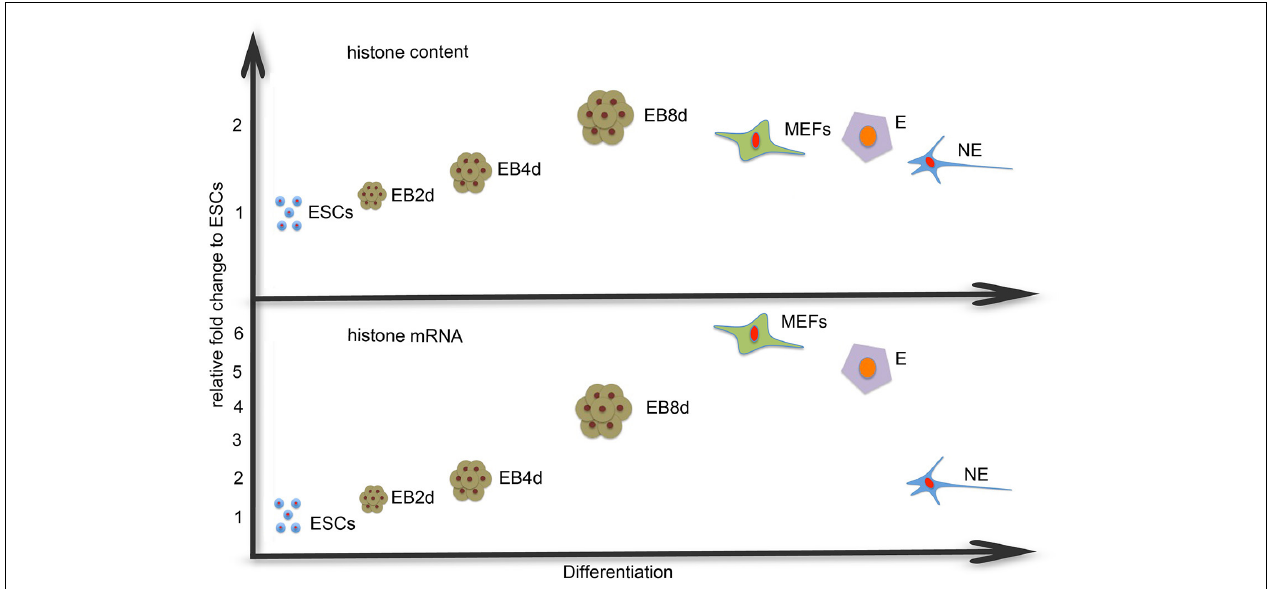
FIGURE 5 | H3 mRNA and protein content vs. differentiation. ESCs express and contain less histone H3 than the differentiated cells. The difference is larger in mRNA levels than in the protein content and there is variability between the various differentiated cell types.